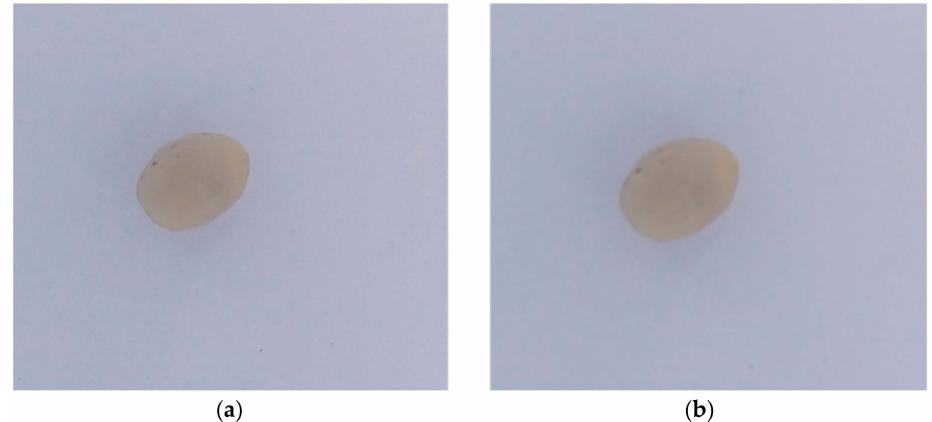
Figure 6. Co ff ee bean images ( a ) without a Gaussian filter and ( b ) with a Gaussian filter.